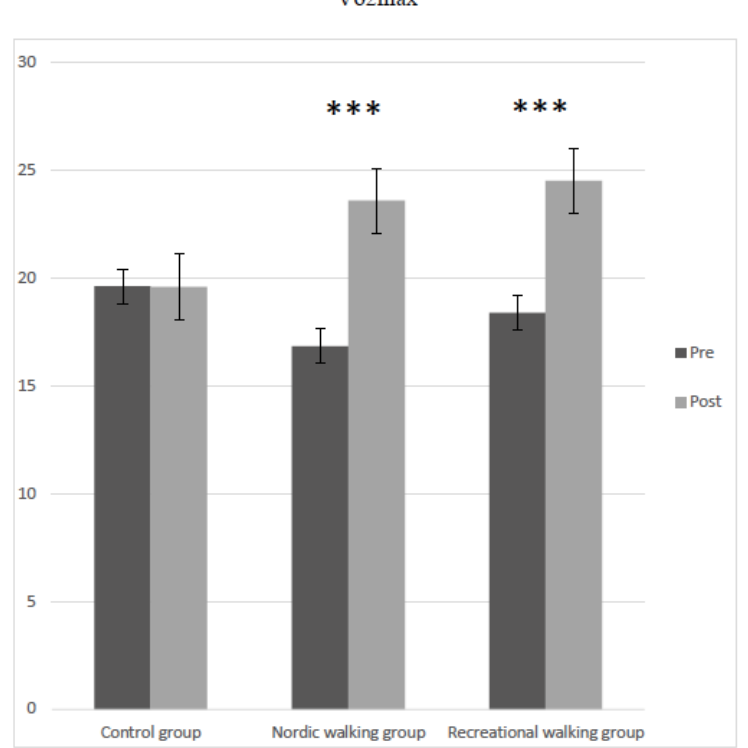
Figure 5. Differences in VO 2 max in pretest and posttest interventions in the three studied groups. *** p < 0.001